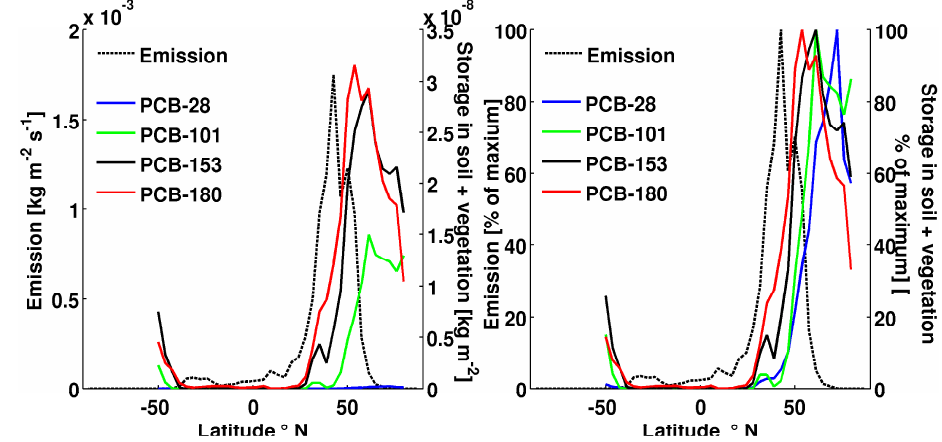
Fig. 2. Global, zonally (longitudinally) averaged soil and vegetation burdens together with accumulated emissions 1950–2010 (grey), absolute terms (left) and normalized to maximum (right). Mean of the year 2010.